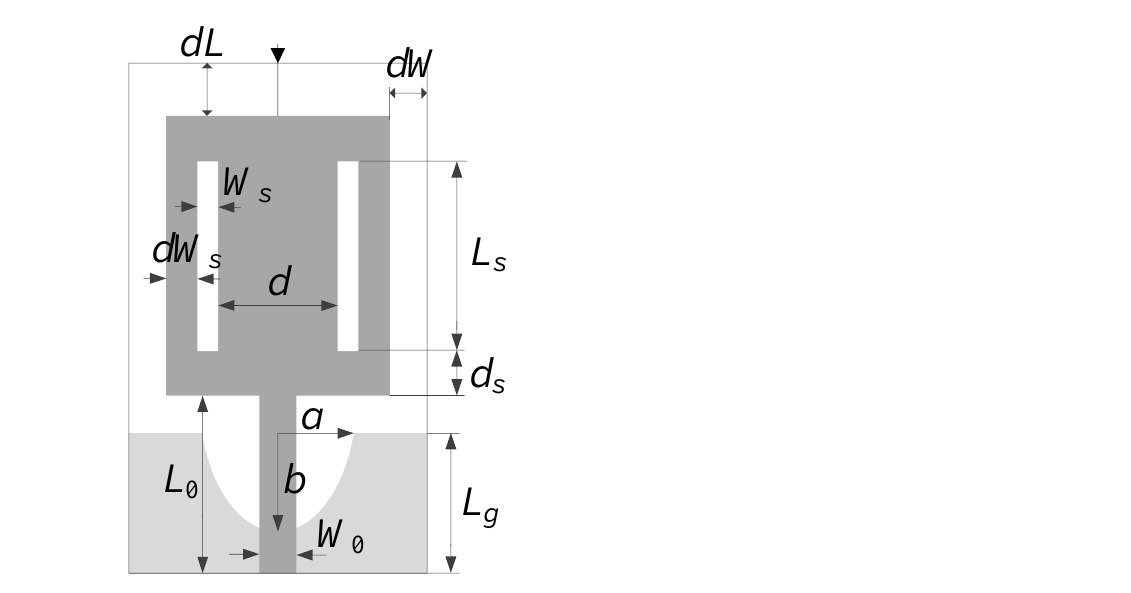
Figure 6. Geometry of Antenna II: the light gray shade is the ground plane on the backside of the structure. Table 2. Optimization results for antenna II.